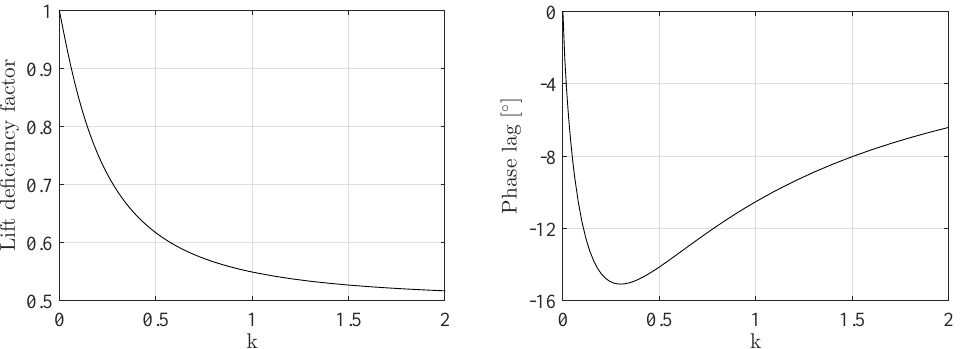
Figure 1. Graphical description of Theodorsen’s lift deficiency and phase lag functions for small amplitude unsteady motions of a flat plate